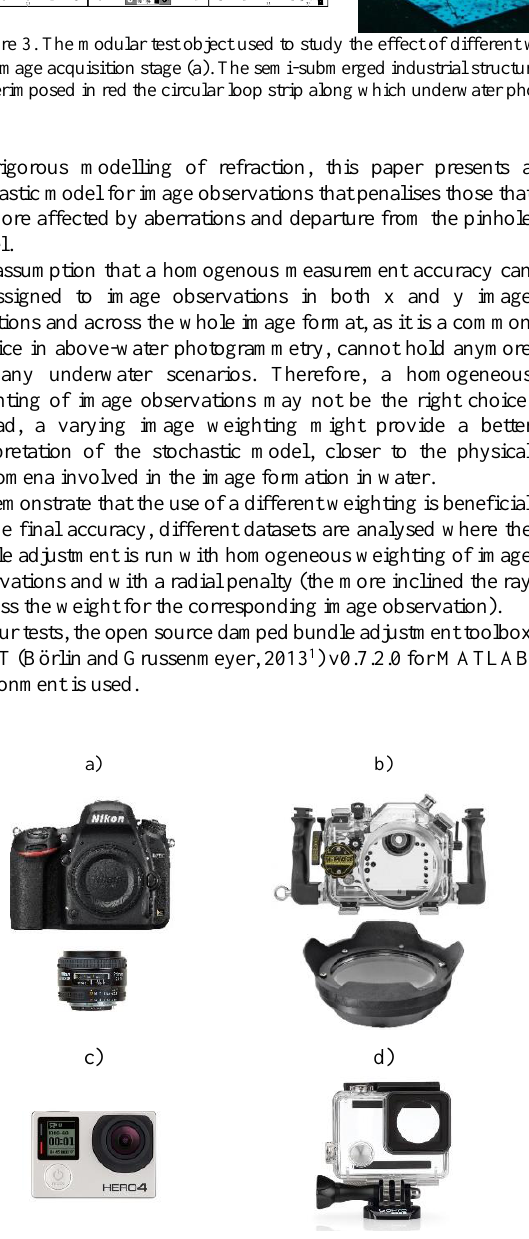
Figure 4. Camera systems and waterproof housing used for the experiments. The Nikon D750 DSLR camera (a) with NiMAR NI3D750ZM pressure housing (b). The GoPro HERO4 Black (c) in its dedicated waterproof housing